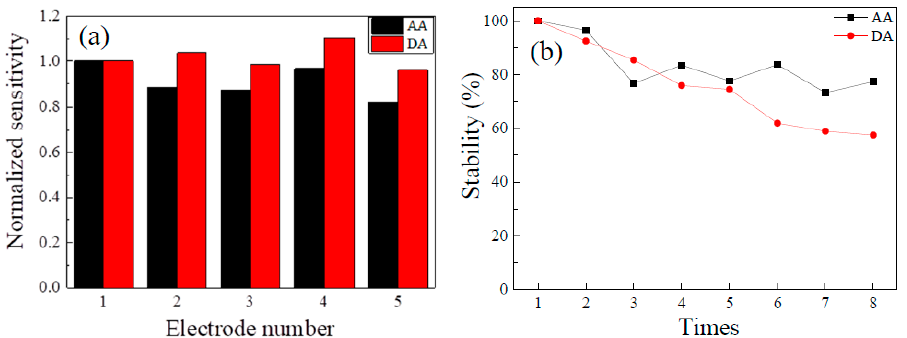
Figure 10. ( a ) Repeatability of the Pt-Mo/C/GCE for the detection of AA and DA; ( b ) stability of the Pt-Mo/C/GCE for the detection of AA and DA.